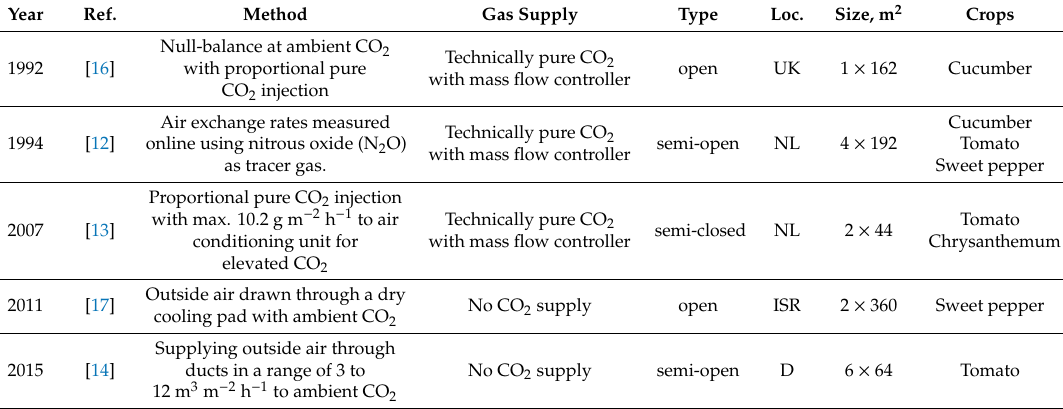
Table 1. Timely development of experimental whole crop gas-exchange greenhouse measurement